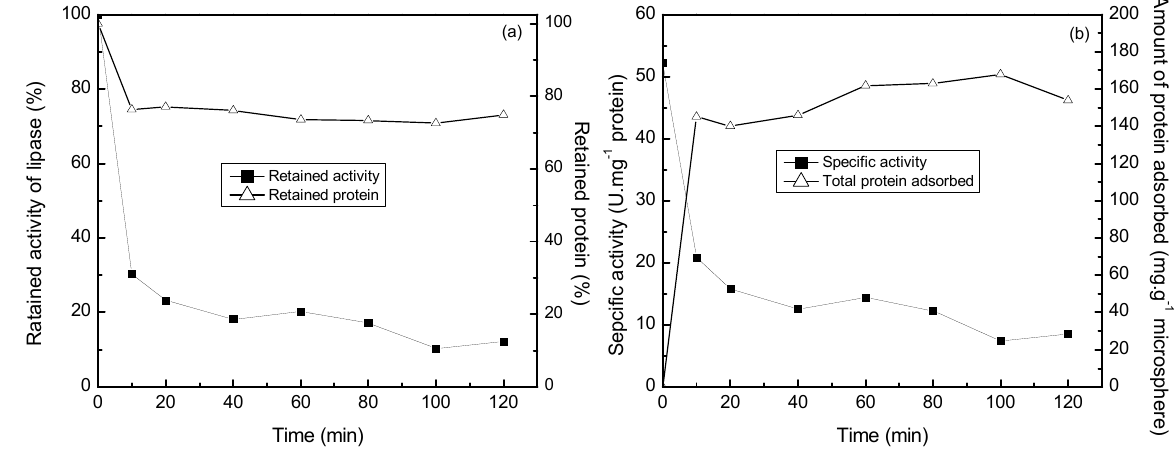
Figure 8. Time profiles of retained activity of lipase and retained protein during adsorption ( a ) specific activity of lipase in solution and the total amount of protein adsorbed by the microsphere ( b ) pH 7.0, 25 °C.